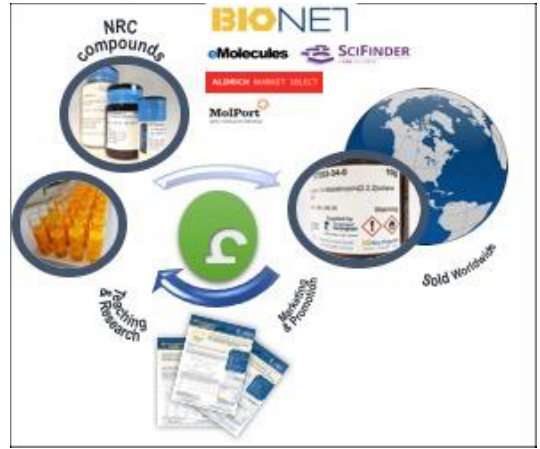
Figure 23. Nottingham Research Chemicals.